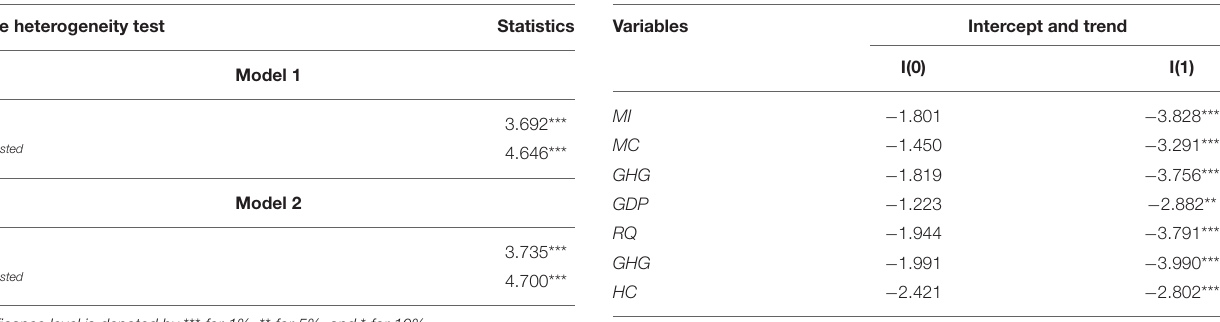
TABLE 4 | Unit root testing (49).